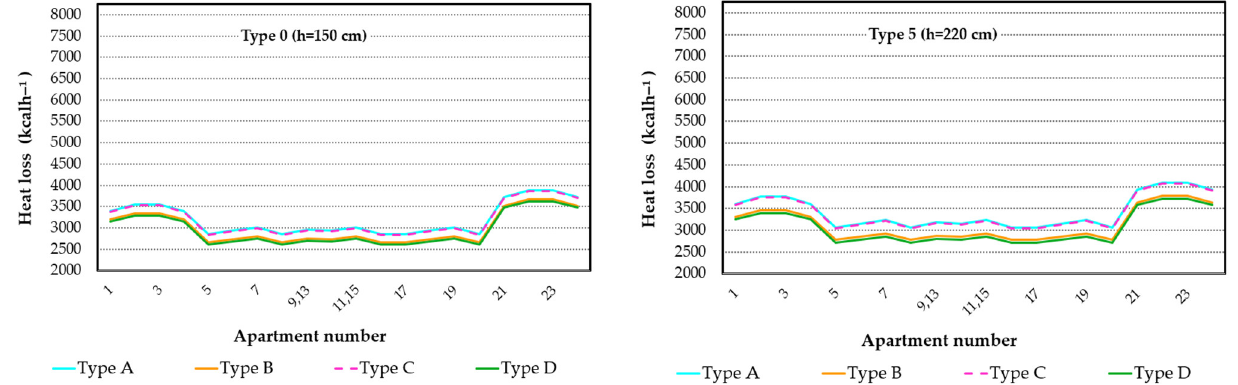
Figure 7. Comparison of window types according to window height (Antalya).